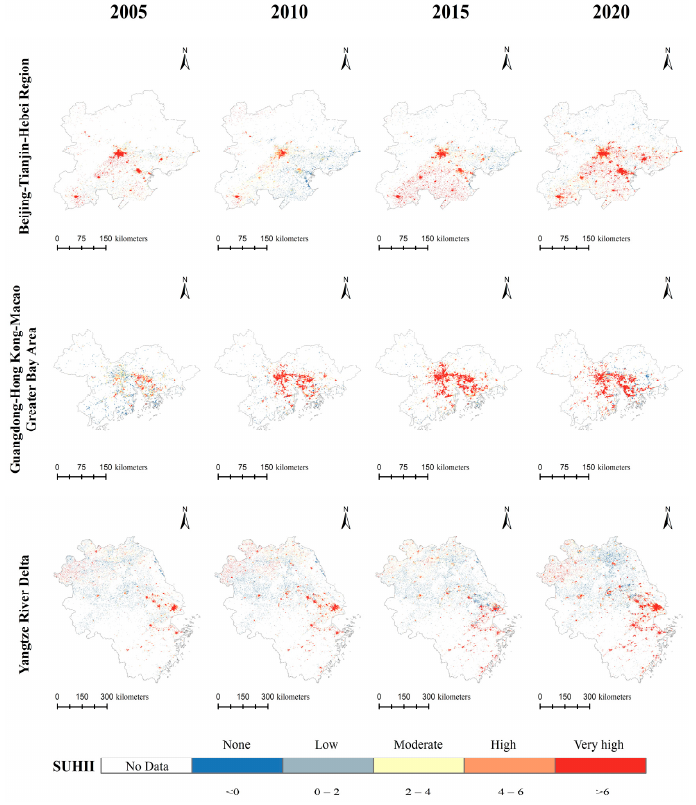
Figure 4. Spatiotemporal dynamics of SUHII in study areas in 2005–2020. From the perspective of spatial distribution, the SUHI of these three urban agglomera- tions is mainly distributed in the areas with the most concentrated construction land: (1) Through calculation, we obtain the area of the heat island region where the SUHII index is greater than zero. The annual average rates of heat island area growth in the three regions are 1.01%, 1.41% and 1.09%, respectively. (2) The spatial distribution of the thermal landscape has changed, showing the characteristics of scattered-contiguous- diffusion transfer. (3) The development of functional relationships between cities